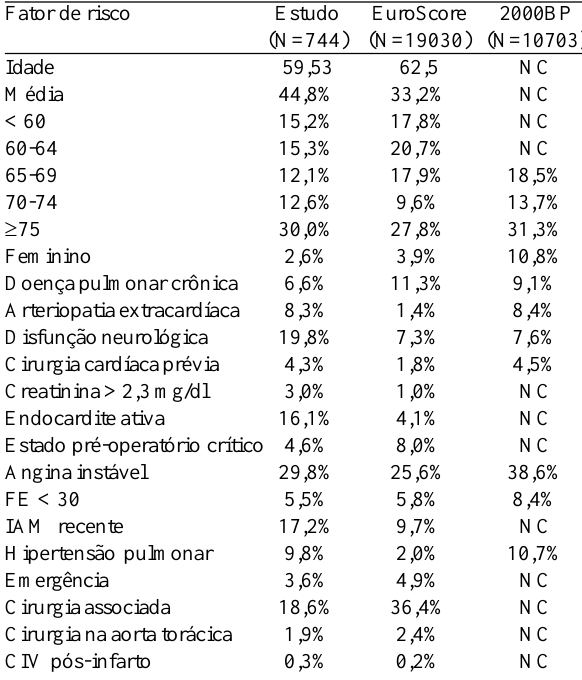
Tabela 2. Prevalência dos fatores de risco no Grupo Estudo, comparado com os fatores de risco da população do Euroscore e do 2000Bernstein Parsonnet.